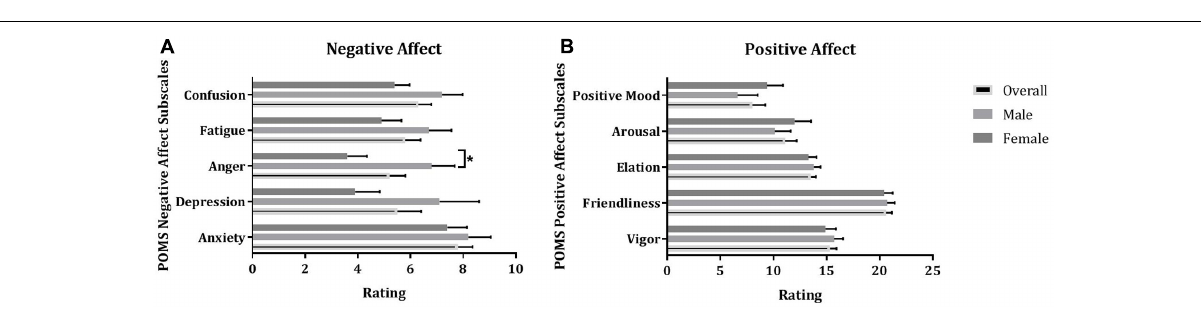
dynamic versions of the same stimulus, e.g., either still or